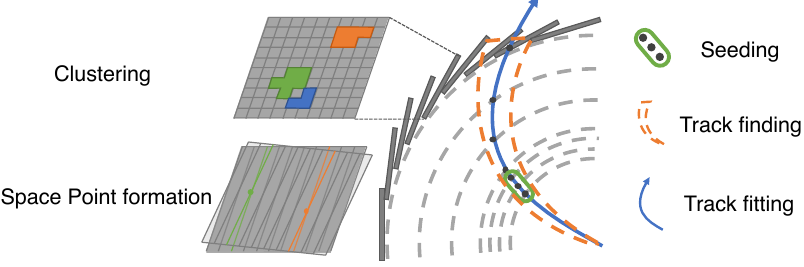
Figure 1. Overview of a possible tracking chain: Clustering, space point formation, seeding, track finding and track fitting.